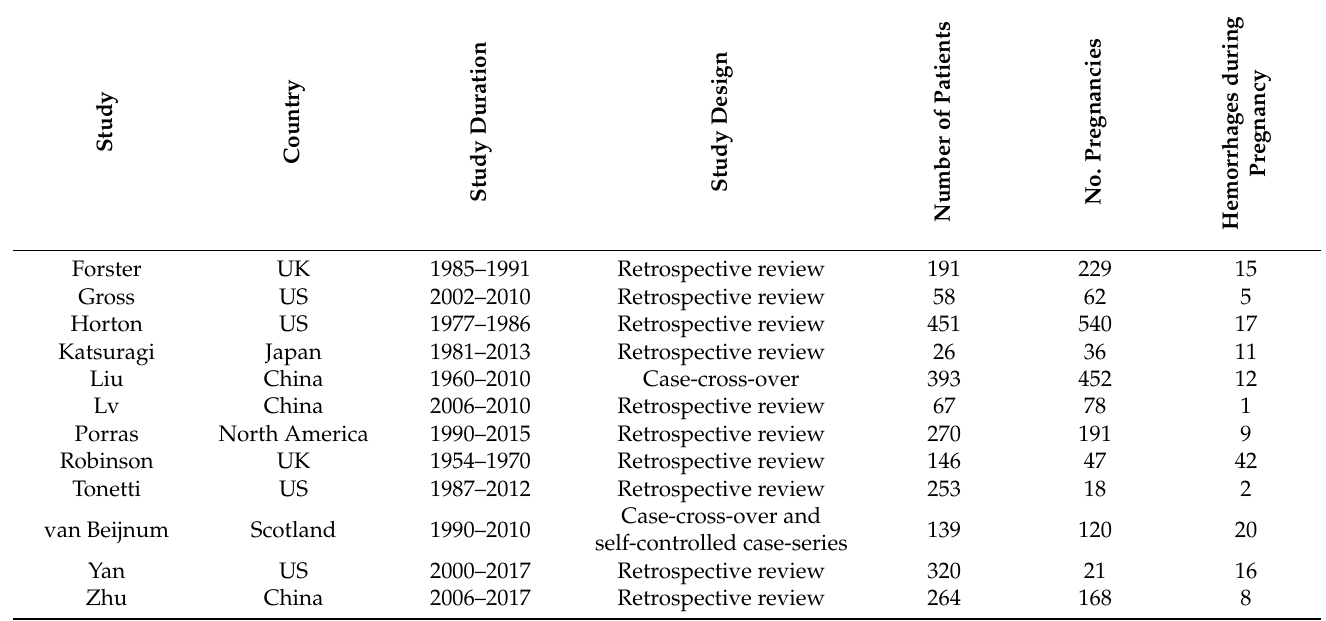
Table 1. Study characteristics of included studies (n = 12).